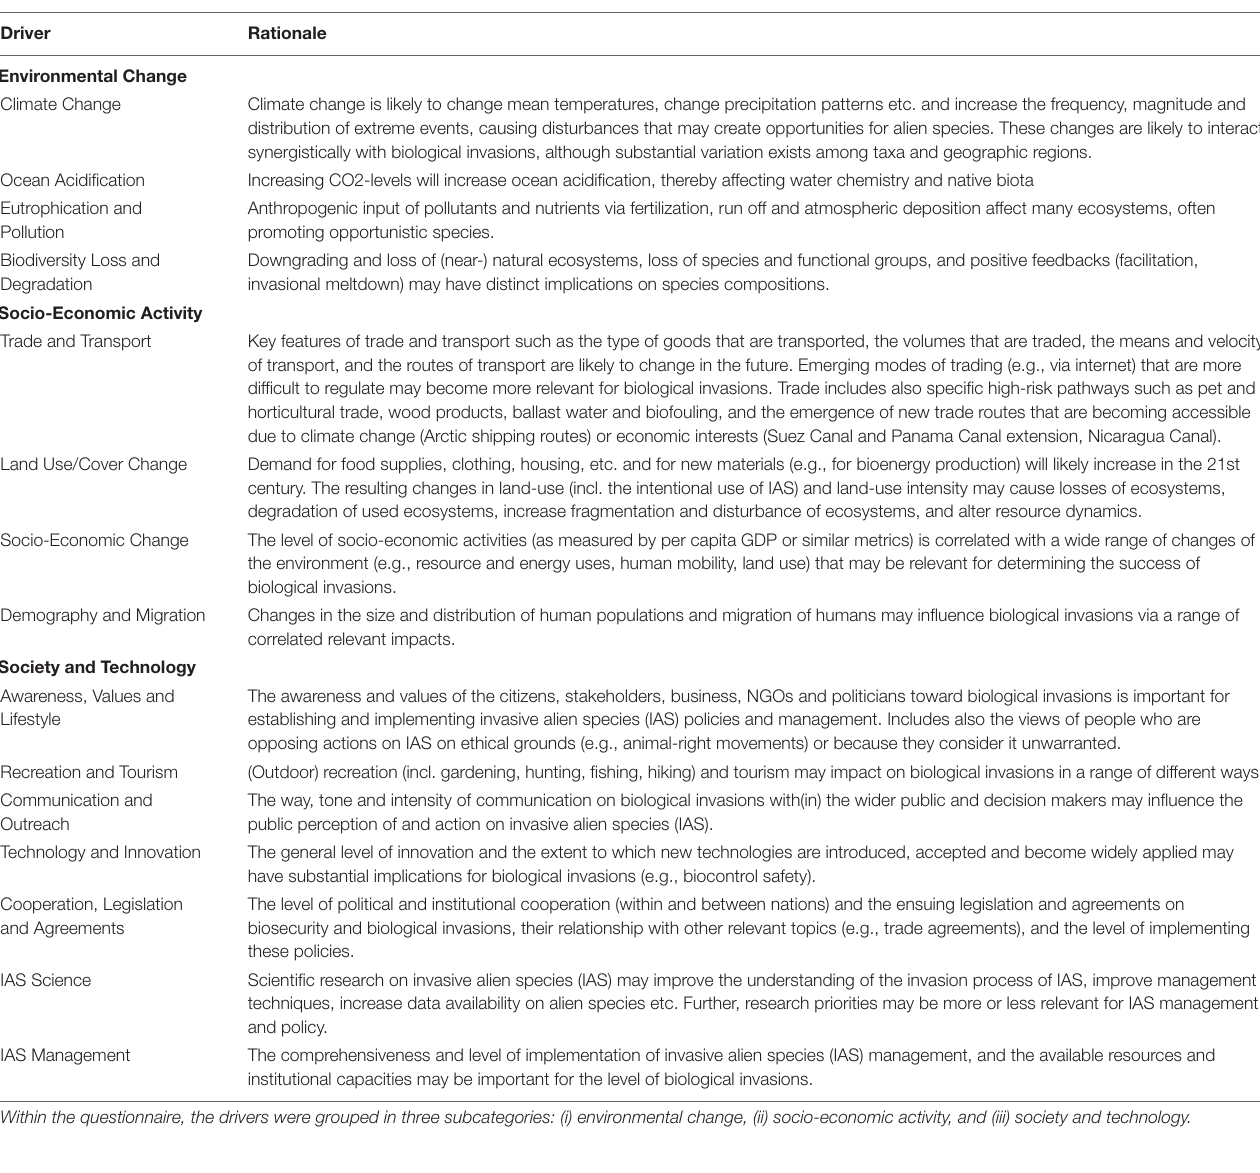
TABLE 1 | Overview table of the 15 drivers used in the survey and their rationale on how they might affect biological